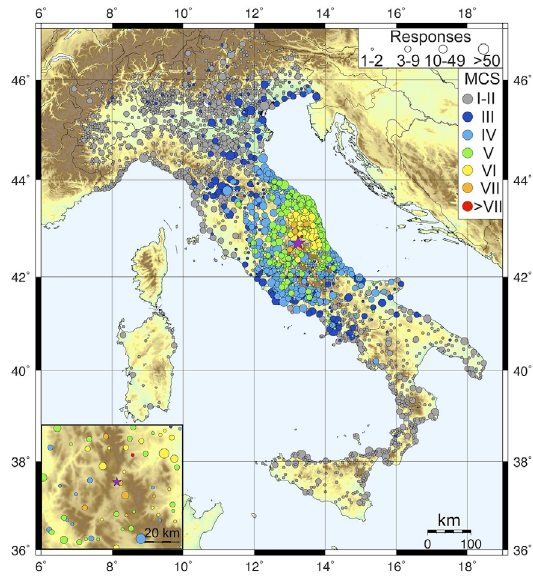
Figure 1. Municipality macroseismic MCS intensities assessed using 11100 questionnaires, compiled through the HSIT site (www.haisentitoilterremoto.it). The purple star represents the instrumental epicenter. The inset shows an enlargement of the epicentral